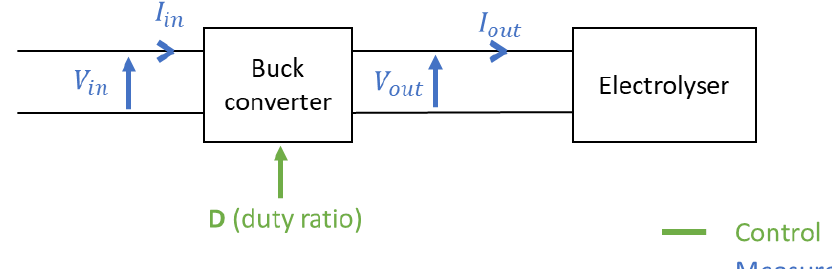
Figure 4. Voltage at the buck converter input and output.